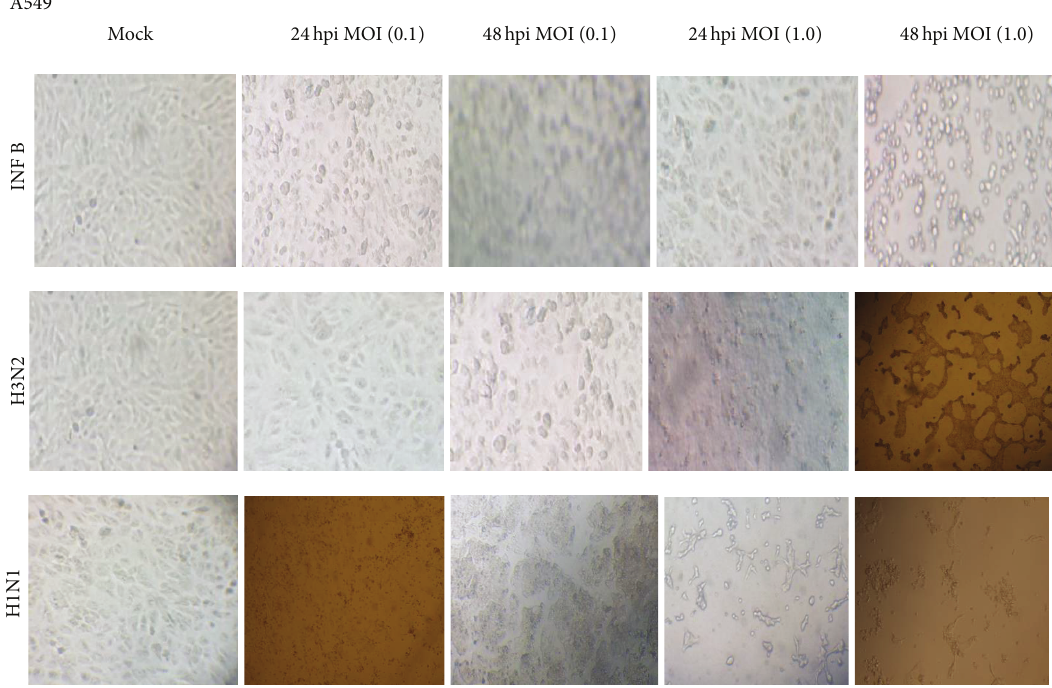
Figure 1: Cytopathogenicity of A549 cells to an influenza A and B viruses infection at 24 and 48 hours after infection (10x magnification).